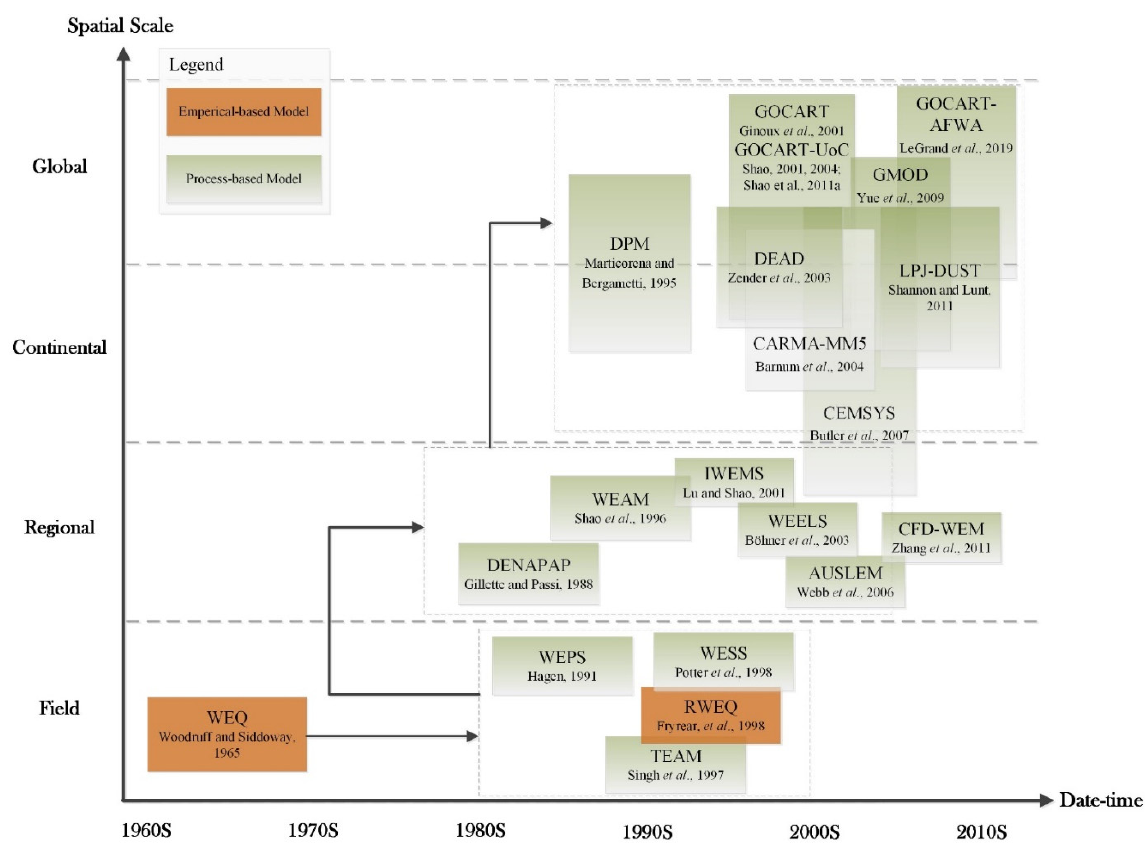
Figure 2. Evolution of wind erosion models. AUSLEM: Australian Land Erodibility Model [91]; CARMA-Dust: Community Aerosol Research Model, by Ames/NASA [86]; CEMSYS: Computational Environmental Management System [87]; CFD-WEM: Computational Fluid Dynamics Wind Erosion Model [53]; DEAD: Dust En-trainment and Deposition [42]; DENAPAP: Dust Emission Model, supported by the National Acid Precipitation Assessment Program [92]; DPM: Dust Production Model [93]; GMOD: Global Transport Model of Dust [43]; GOCART: Global Ozone Chemistry Aerosol Radiation and Transport [94]; GOCART—AFWA: GOCART—Air Force Weather Agency [88]; GOCART—UoC: GOCART—University of Cologne [11,89,90]; IWEMS: Integrated Wind Erosion Modeling System [40]; LPJ—dust version 1.0: Lund–Potsdam–Jena dynamic global vegetation model—dust version 1.0 [95]; RWEQ: Revised Wind Erosion Equation [82]; TEAM: Texas Erosion Analysis Model [84]; WEAM: Wind Erosion Assessment Model [85]; WEELS: Wind Erosion on European Light Soils [41]; WEPS: Wind Erosion Prediction System [39]; WEQ: Wind Erosion Equation [38]; WESS: Wind Erosion Stochastic Simulator[83].